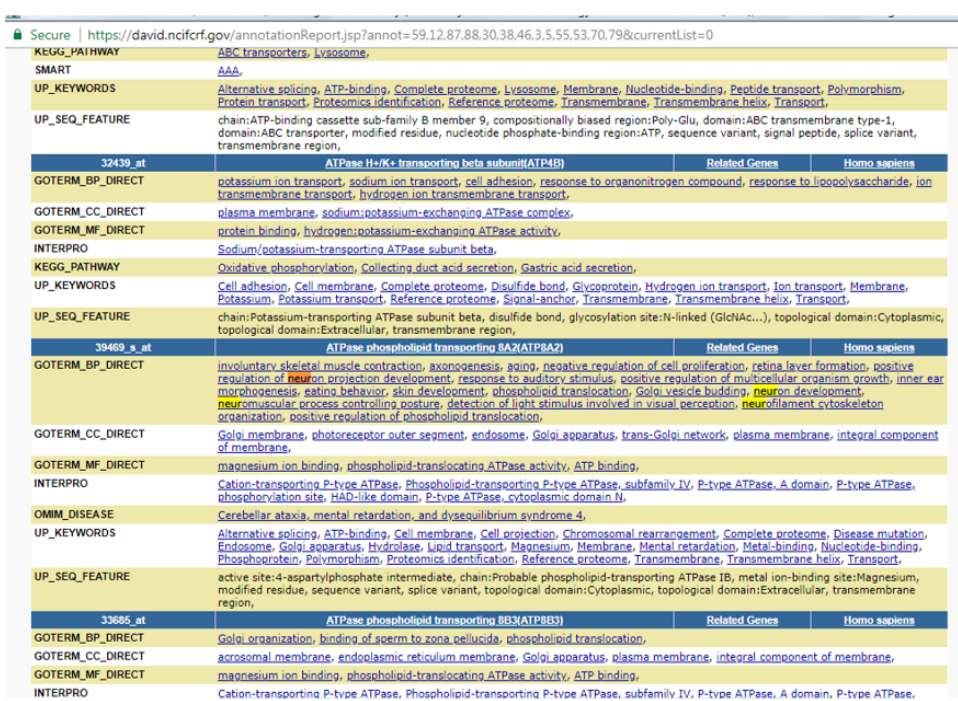
Figure 7. Keyword search. Screenshot of a keyword search of the DAVID output to identify genes that are relevant to a given biological function. In this case the search term is “neur” (highlighted in yellow), to identify genes related to neurological processes. The keyword search is done via the general search function on your computer. For larger gene sets, a computer program may be used.